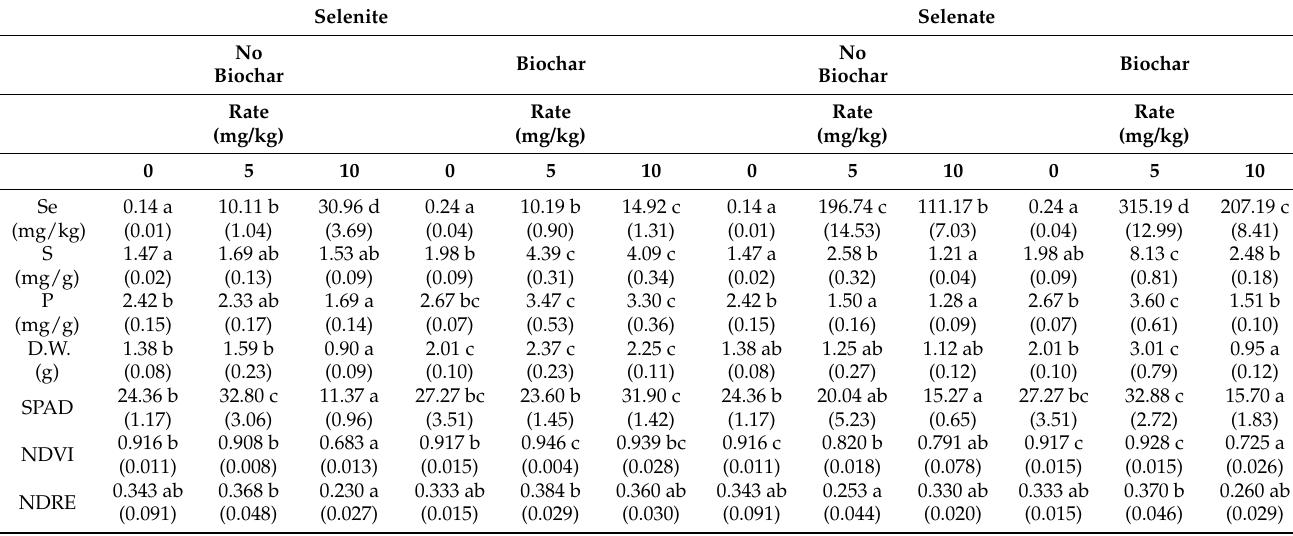
Table 2. Se, S, and P concentrations in lettuce plants and plant growth characteristics. Comparisons between treatments means performed by Tukey’s HSD test and are valid within each Se species, i.e., selenite or selenate ( p < 0.05). (Standard deviation in parenthesis, different lowercase letter indicates significant